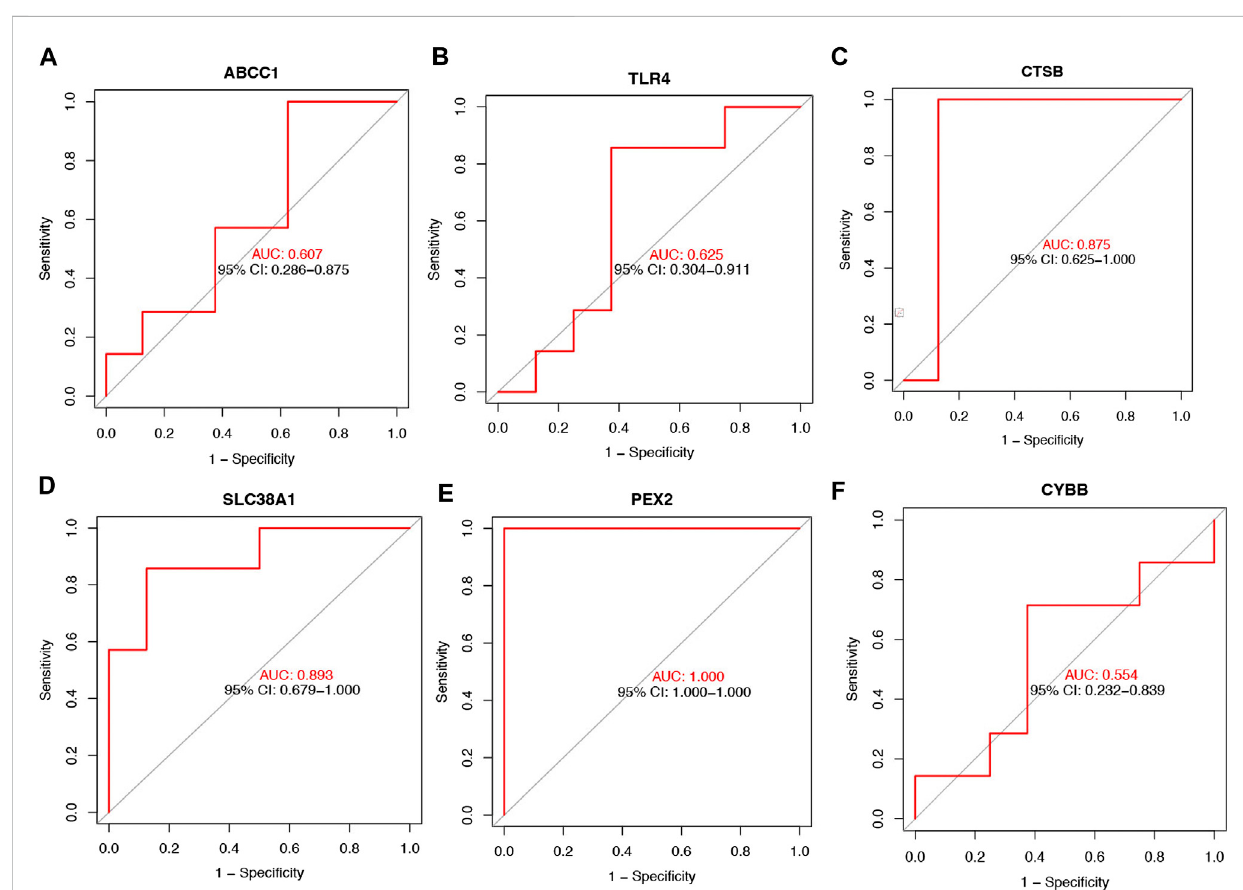
FIGURE 3 The ROC curve of six FRGs in the lacrimal gland tissue from TAO patients and the health (A – F) .